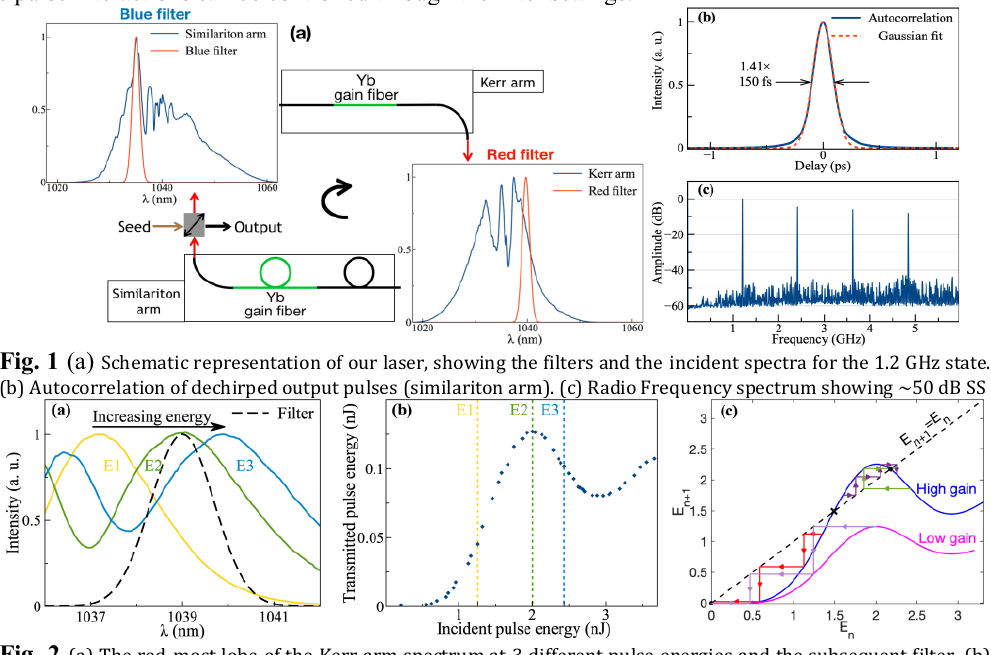
Fig. 2 (a) The red-most lobe of the Kerr arm spectrum at 3 different pulse energies and the subsequent filter.